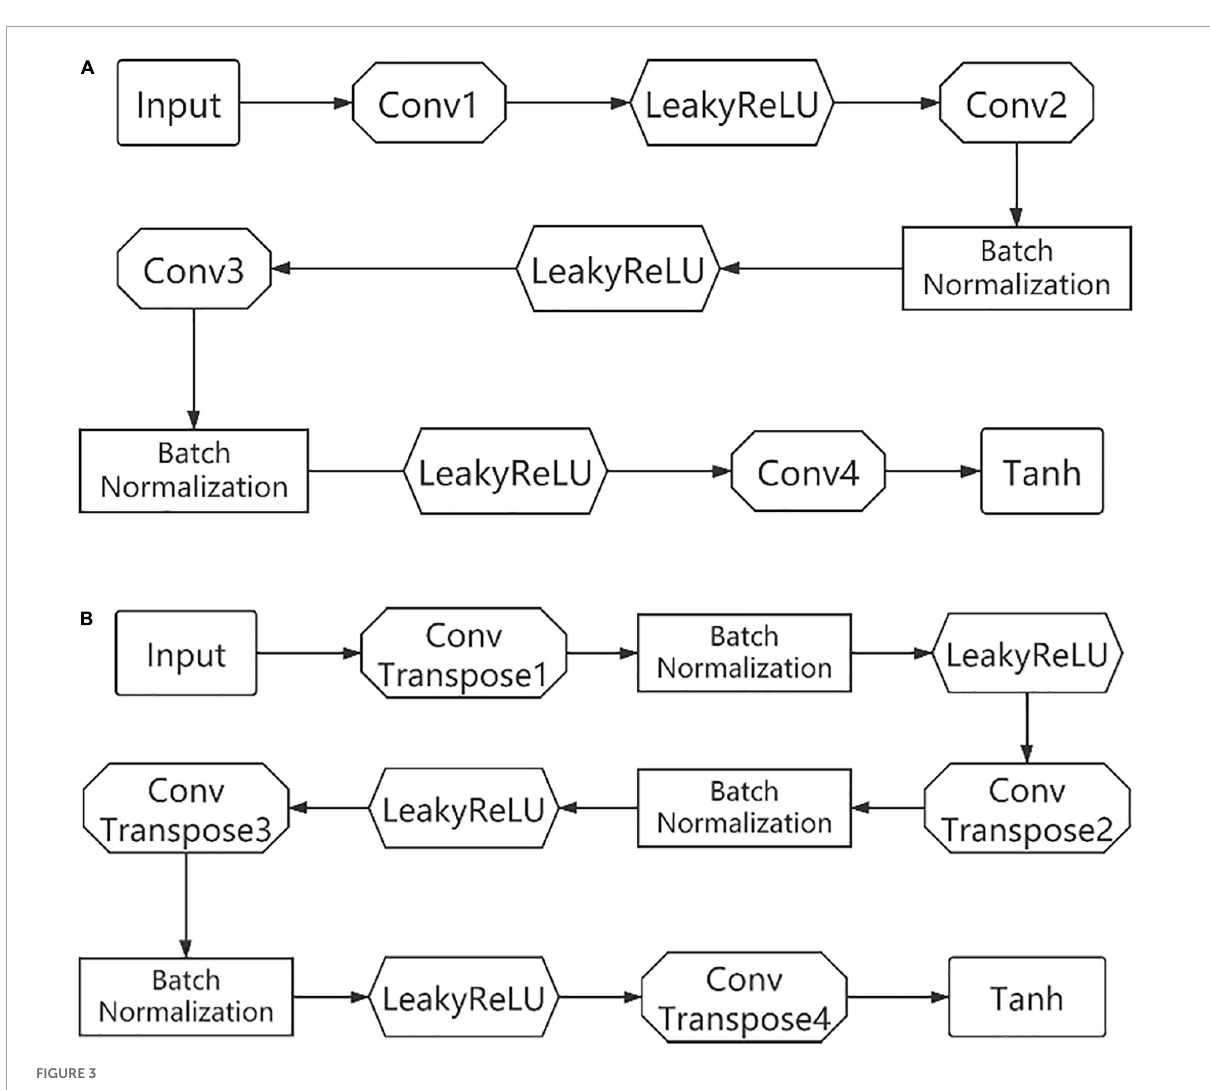
FIGURE3 The specific structure of the encoder (A) and decoder (B)